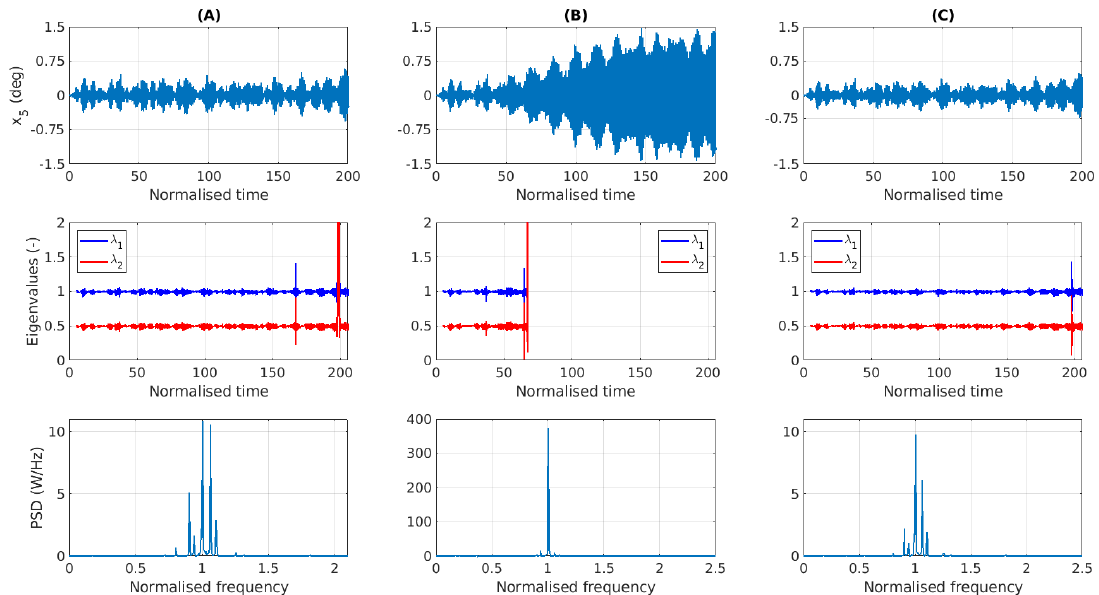
Figure 15. The time series for the pitch displacement ( top ), the magnitudes of the eigenvalues of the matrix A ( middle ) and the PSD of the pitch displacement ( bottom ), for the points (A) A, (B) B and (C) C in Figure 14.